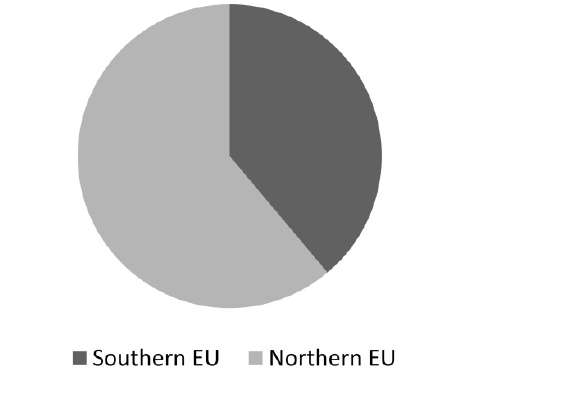
Figure 1. Incidence and prevention in endemic southern and in non-endemic northern